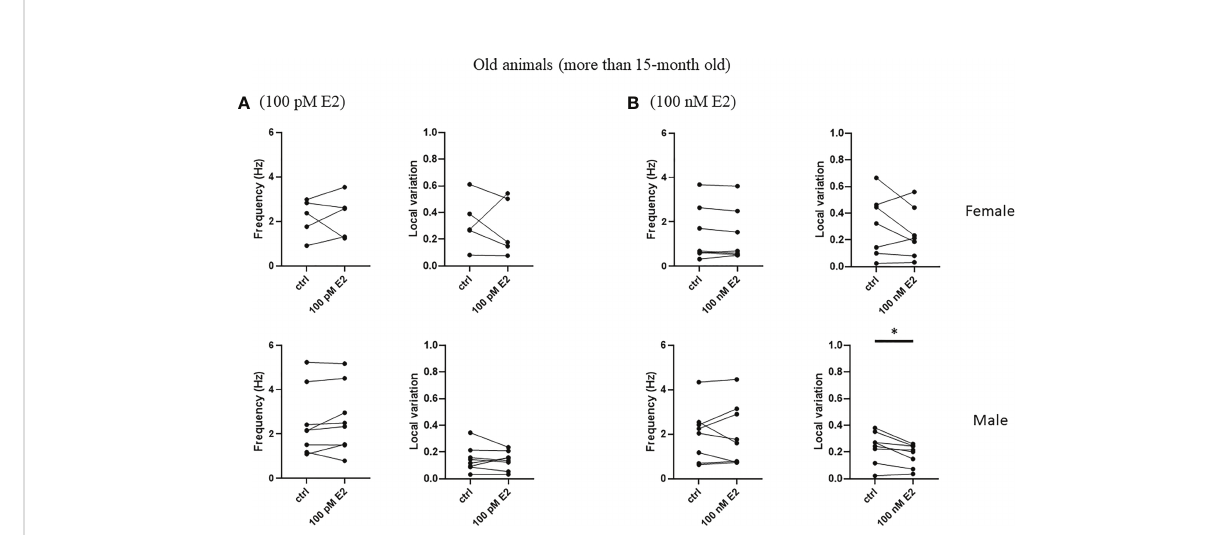
FIGURE 9 Rapid effect of 17 b -estradiol on spontaneous activity of cholinergic interneurons in old animals.The effect of 100 pM or 100 nM 17 b -estradiol in 5 minutes on spontaneous activity of cholinergic interneurons are shown in Panels (A, B) , respectively. *p< 0.05.